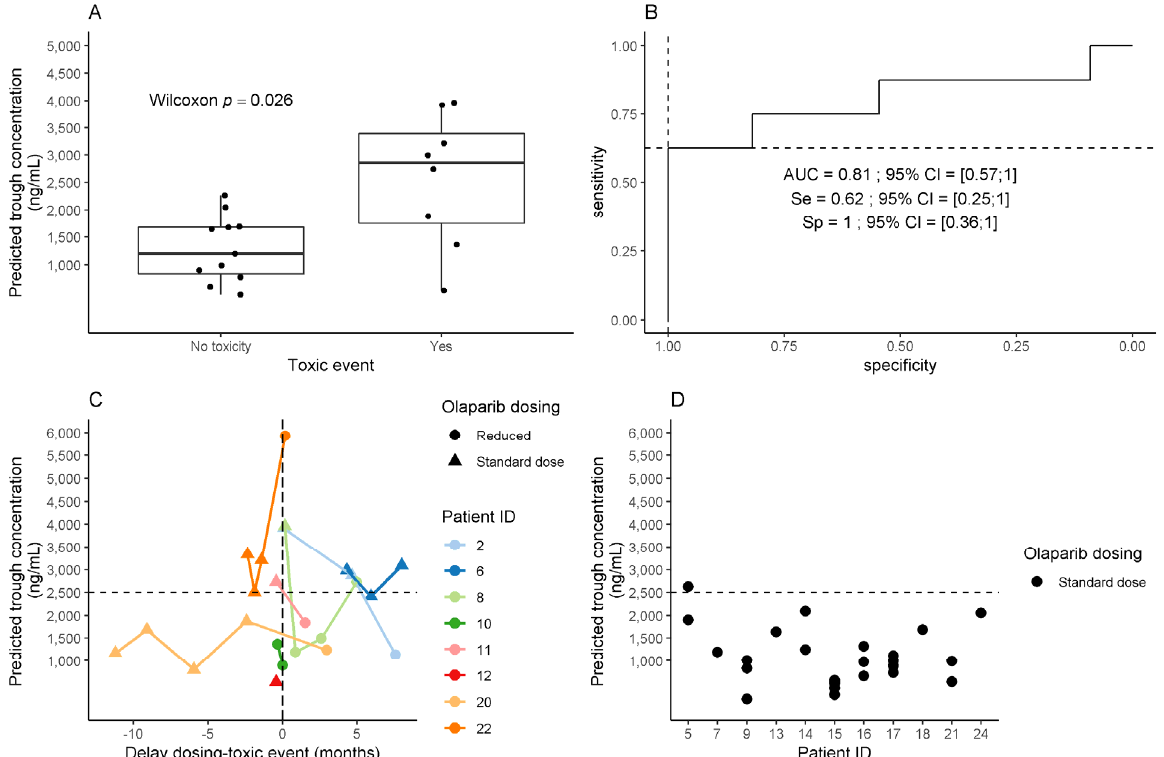
Figure 4. Association between olaparib predicted trough concentration (C minPred ) and onset of olaparib-related clinically sig- nificant adverse events (SAE). The black dashed line indicates the threshold identified by ROC curve analysis (2500 ng/mL). ( A ) Olaparib C minPred in patients with or without olaparib-related SAE. Toxic event refers to SAE onset. ( B ) Performances of olaparib C minPred for prediction of olaparib-related SAE (ROC curve). Se: sensitivity. Sp: specificity. AUC: area under curve. The 95% confidence intervals were computed by 2000 stratified bootstrap replicates. ( C ) Olaparib C minPred in patients who experienced a SAE. Patients included in this analysis are patients who experienced a SAE, with an olaparib exposure assessment at SAE onset (+/ − 6 months around SAE). ( D ) Olaparib predicted trough concentration (C minPred ) in patients without olaparib-related adverse event. Patients included in this analysis are patients with at least one plasma concentration available, and no adverse event within the six months